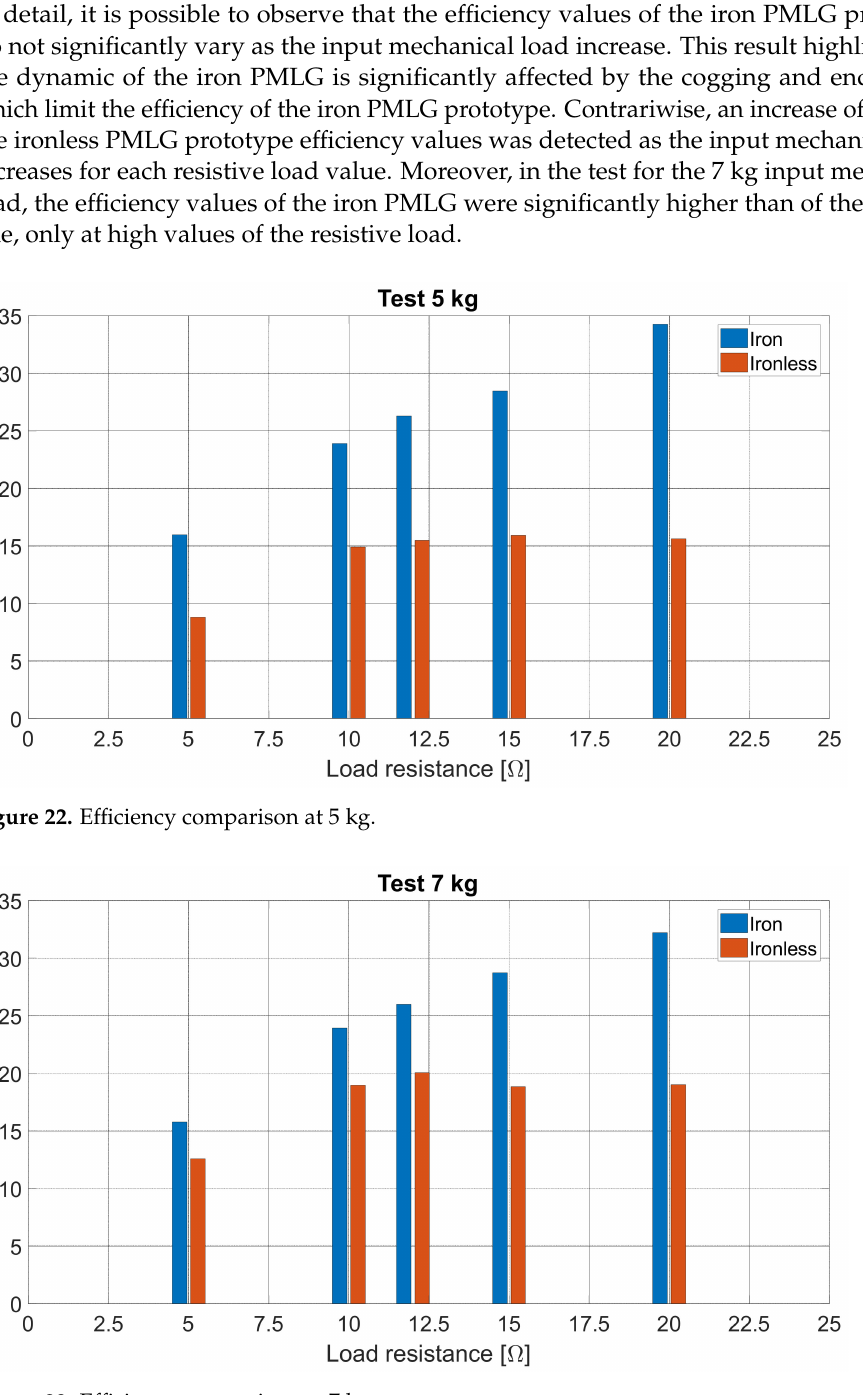
Figure 23. Efficiency comparison at 7